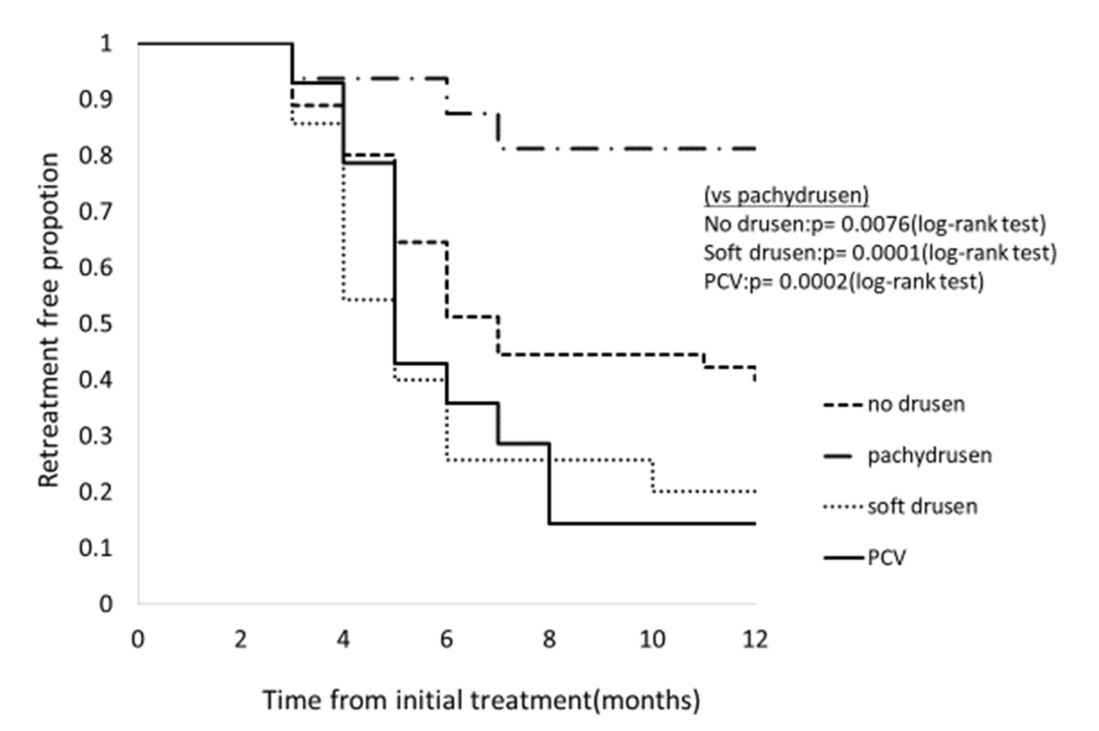
Figure 6. Kaplan–Meier estimator showing retreatment-free proportion after initial treatment according to the groups. Retreatment-free proportion at 12 months was 83.3% (13 / 16), 41.2% (19 / 45), 20% (7 / 35), 14.3% (2 / 14) in pachydrusen group, no drusen group, and PCV / Scarring group, respectively. Retreatment-free period was significantly longer in pachydrusen group compared to other groups. (all p -value < 0.001). Mean number of additional injections was significantly smaller in Group 1 (0.5 ± 1.32) compared with other groups. (Group 2: 1.73 ± 2.08, p = 7.5 × 10 -3 ; Group 3: 2.71 ± 1.99, p = 1.4 × 10 -4 ; Group 4: 2.71 ± 2.16, p = 4.0 × 10 -4